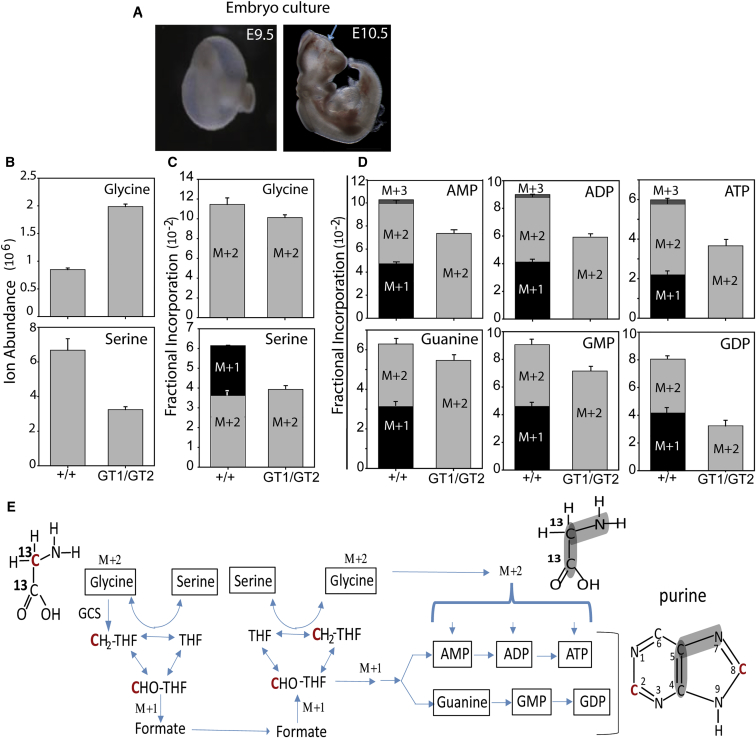
Glycine Is a 1C Donor in Neurulation-Stage Embryos(A) Labeling with [1,2-13C] glycine was performed in whole-embryo culture with the yolk sac intact until E10.5 (typical stage of embryos after culture is shown; the arrow indicates cranial NTD in a GldcGT1/GT2 embryo).(B) The ion abundance of labeled glycine was elevated in Gldc-null embryos compared with wild-types (n = 5 embryos per genotype).(C–E) Fractional incorporation of labeled glycine was approximately 10% of total (C). Glycine was incorporated intact into serine (C) and purines (D and E), in which it contributes C4 and C5. In wild-type embryos, M+1 labeling of serine and purines (at C2 or C8) was also detected, implying GCS-mediated cleavage of glycine to generate 5,10-methylene THF and transfer of the 1C unit (indicated in red) via formate to formyl-THF in the cytoplasm (E). No M+1 or M+3 labeling of serine or purines was detected in Gldc-null embryos.